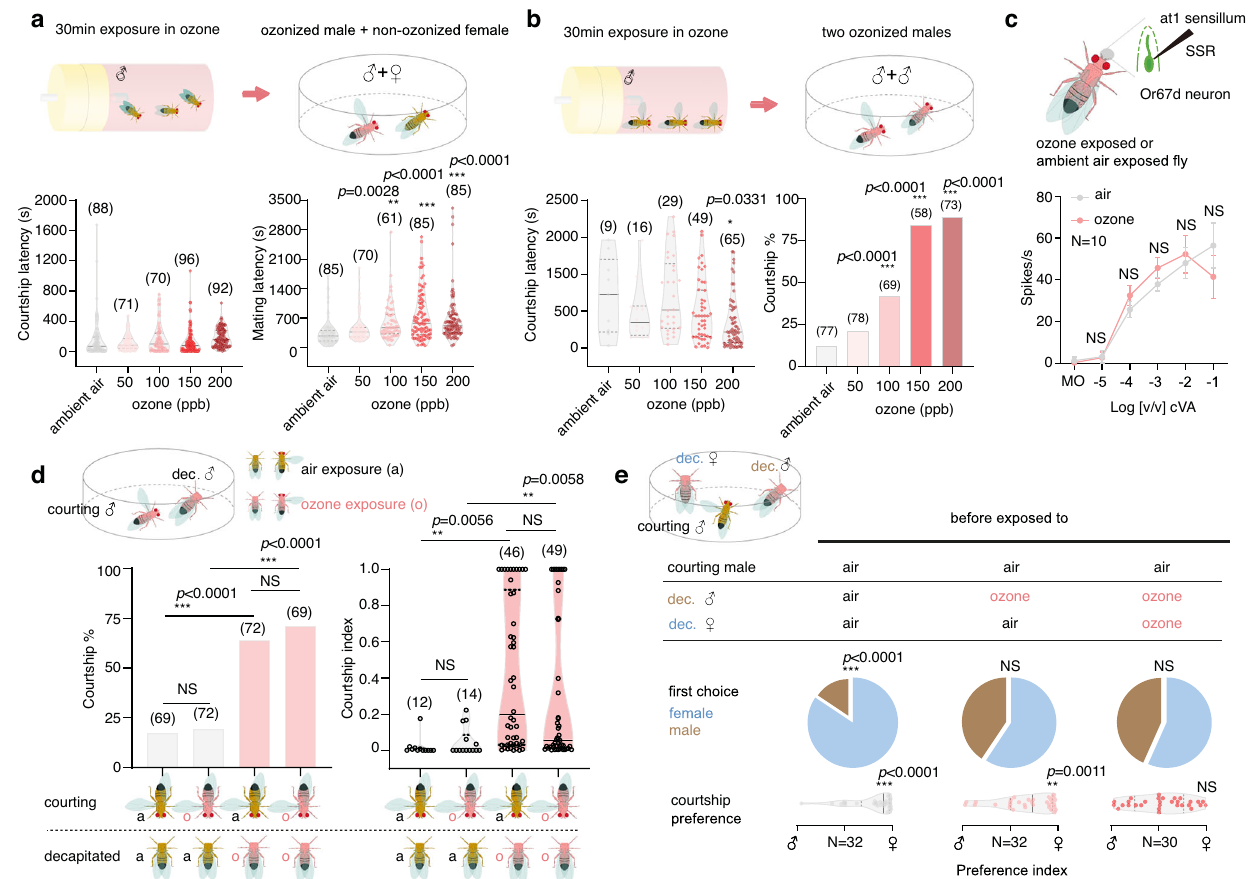
Fig. 2 | Ozone exposure disrupts D. melanogaster (CS) ’ s sex discrimination. a Male/female courtship latency and mating latency after male exposure to dif- ferentlevelsof ozone(samplesizeprovidedinbrackets, Dunnett ’ s testformultiple comparisons against the ambient air control; groups signi fi cantly differing from control: * p <0.05; ** p <0.01; *** p <0.001). b Male/male courtship behavior after both males had been exposed to ozone. Courtship latency, Dunnett ’ s test for multiple comparisons; courtship percentage (percentage of experiments that resulted in courting males), Fisher ’ s exact test with Holm-Bonferroni correction for multiplecomparisonwithcontrolgroup;signi fi cantdifferencestocontroldepicted asabove. c SSR dose response curve of Or67d neuron (at1 sensillum) from male D. melanogaster . Top panel, schematic of SSR procedure; data presented as mean± SE, N =10 for either air or ozone exposure ( t -test for each concentration; NS